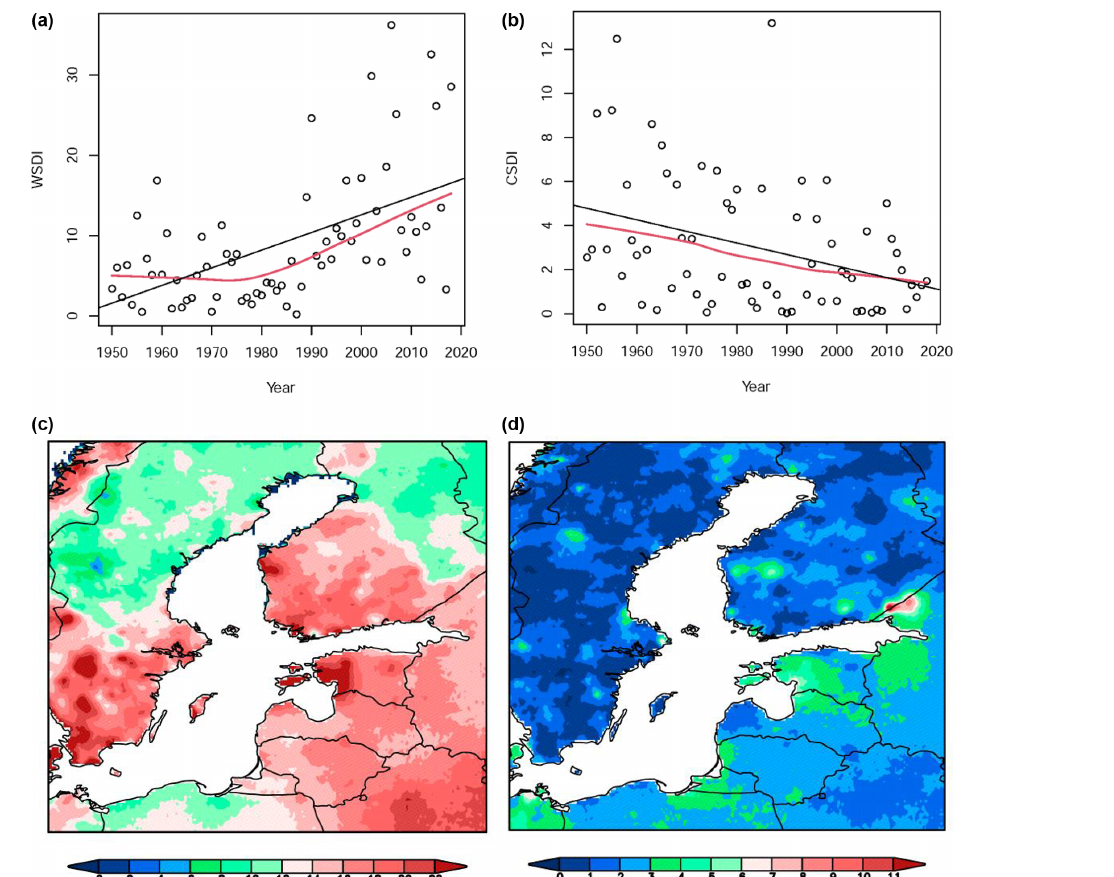
Figure 8. Annual warm spell duration index (WSDI; a ) and annual cold spell duration index (CSDI; b ). (a, b) Time series of the spatial averages over the area from 53 to 67 ◦ N and from 12 to 31 ◦ E in 1950–2018. A fitted curve and a linear fit are also shown. (c, d) Spatial distributions of the 30-year means during the 1989–2018 period. The baseline period in the calculations is 1961–1990. The figure is based on wsdiETCCDI and csdiETCCDI data (Cornes et al., 2018) that were generated by climind 1.0.0 on 19 November